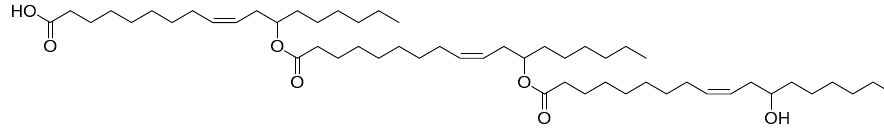
Figure 1. An estolide trimer based on ricinoleic acid.